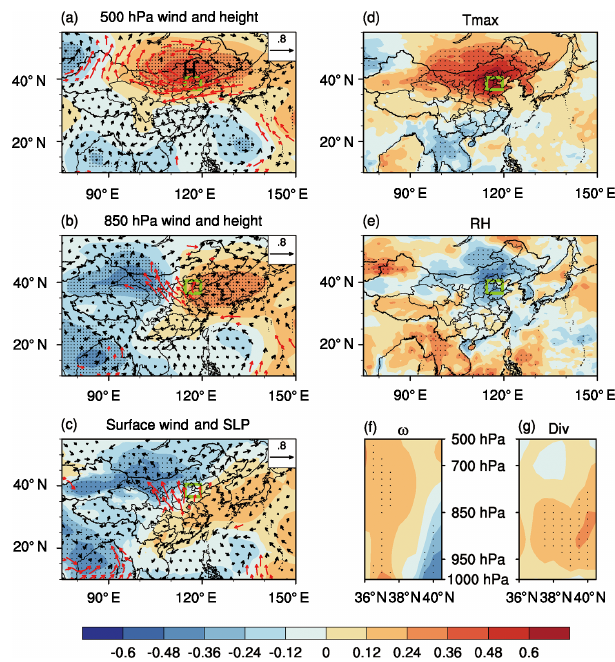
Figure 4. Composites of (a) wind field and geopotential height at 500hPa, (b) wind field and geopotential height at 850hPa, (c) sur- face wind field and SLP, (d) Tmax at the surface, (e) RH at the sur- face, (f) pressure–latitude cross section of vertical pressure velocity ( ω , positive value indicates downward air flow), and (g) pressure– latitude cross section of divergence (positive value indicates diver- gence) for the 21 OPEs in North China. The data shown are com- posited over the standardized time series during the months of May to July of 2014–2017 (see Sect. 2.2). The solid green lines indicate North China. The red vectors in (a) – (c) and black dots in (a) – (g) are significant winds and parameters at 95% confidence.The cross sections are averaged over the longitudes of 114.5–119.5 ◦